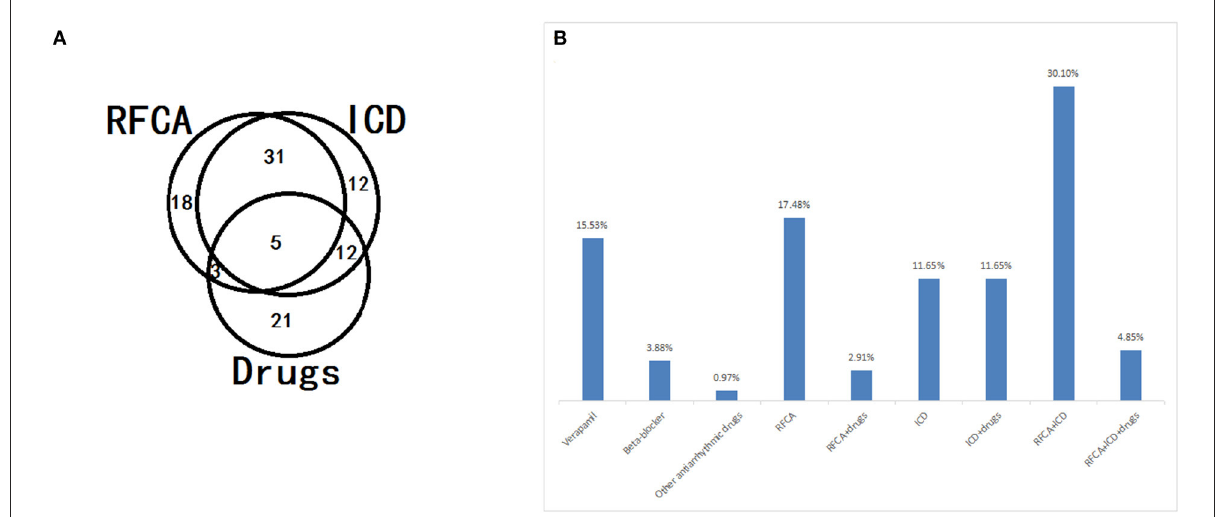
FIGURE5 Application distribution (A) and constitution (B) of different treatment strategies, including radiofrequency catheter ablation (RFCA), implantable cardioverter defibrillator (ICD), and drugs, in patients with short-coupled variant of torsade de pointes